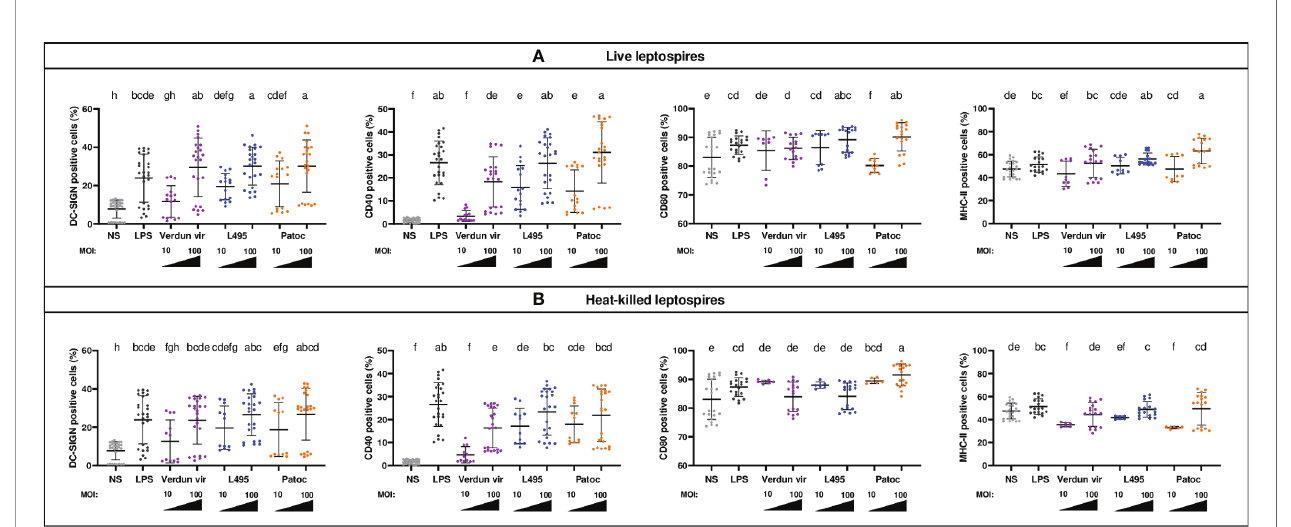
FIGURE 1 | BM-DCs from C57BL/6 mice exposed to live and heat-killed leptospires express more cell surface markers. Day 8 BM-DCs from C57BL/6 mice were exposed for 24h to either live (A) or heat-killed (B) Icterohaemorrhagiae Verdun vir, Manilae L495 and Patoc leptospires at a Multiplicity of Infection (MOI) of 10 or 100 bacteria per cell. E . coli LPS (1 µg/mL) was used as a positive control for DCs stimulation. After 24h, cells were immunostained for the analysis of the expression of DC-SIGN, CD40, CD80 and MHC-II markers by fl ow cytometry and data were compared to results with non-stimulated cells (NS). Data are represented in dot plot diagrams showing the percentage of BM-DCs positive for DC-SIGN, CD40, CD80 and MHC-II staining. Each dot represents one out of four replicates of stimulation from fi ve independent experiments with n=6 mice. Mean ± standard deviation (SD) is also represented (black lines). Statistics indicated above graphs with lower-case letters allow for comparing and ranking (from a, the most upregulated to h, the less upregulated) for each marker, all conditions within live (upper panel) and heat-killed (lower panel). Conditions that share the same lower-case letters are not signi fi cantly different (p > 0.05). In contrast, conditions that do not share same letter(s) are signi fi cantly